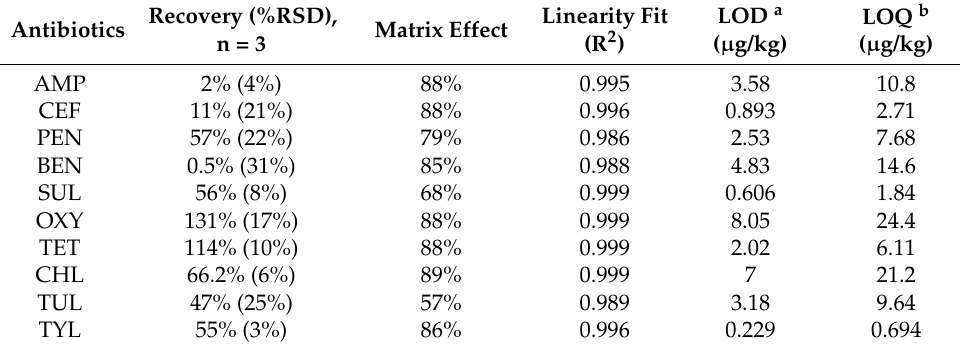
Table 4. Method performance parameters for the two-step extraction of antibiotics from manure using Method